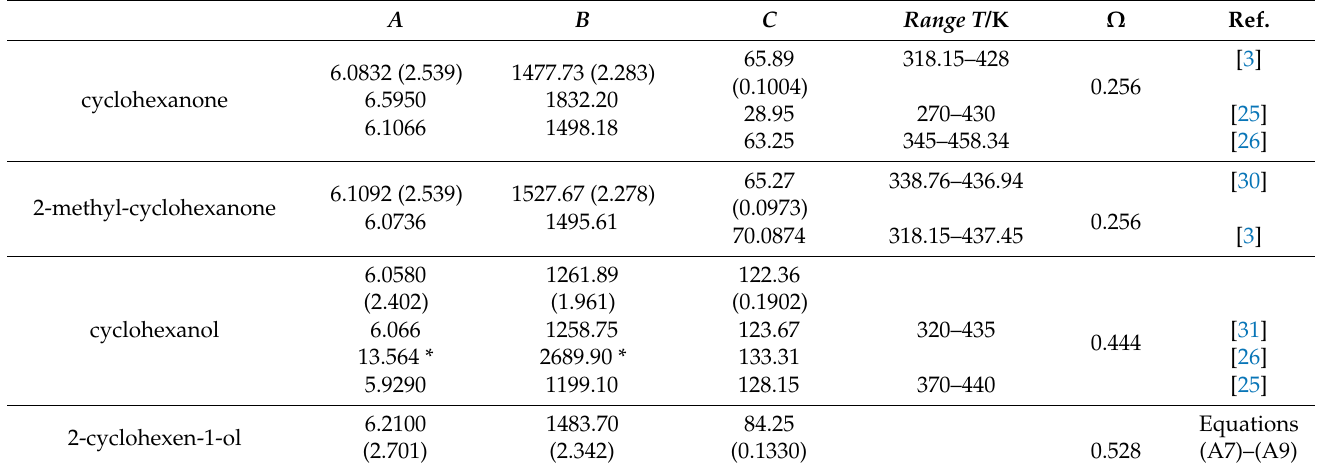
Table A2. Values for the parameters of Antoine’s equation to calculate the vapor pressures. A B C Range T /K Ω Ref.